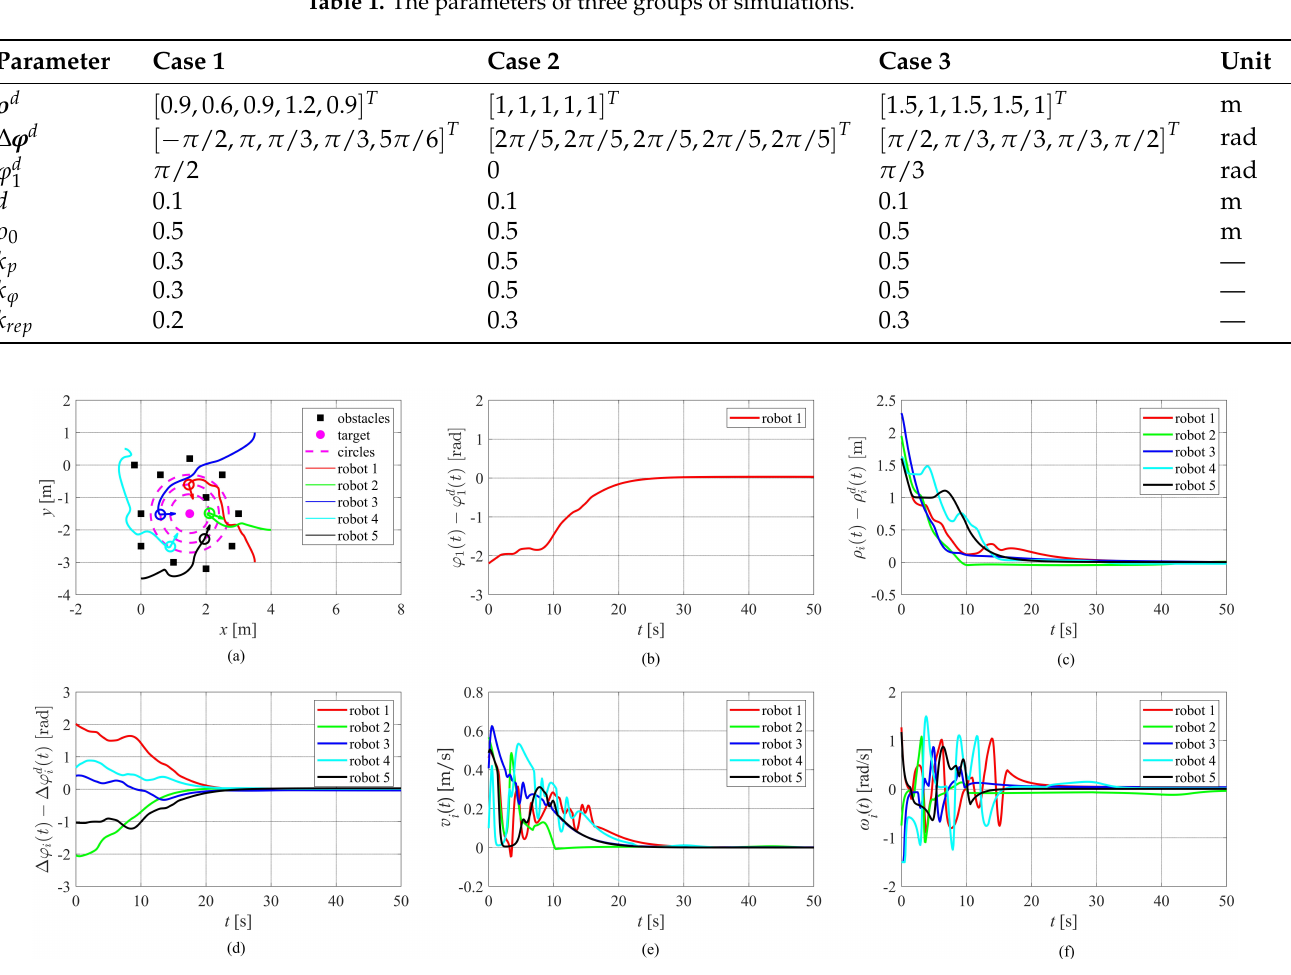
Figure 3. Simulation results of case 1. ( a ) Trajectories of five robots and a static target in a plane. ( b ) Error between current phase and the desired phase of robot 1. ( c ) Distance errors between five robots and their desired circles centered on the target. ( d ) Errors between current angular spacing and the desired angular spacing of all adjacent inter-robots. ( e ) The linear speeds of five robots. ( f ) The angular speeds of five